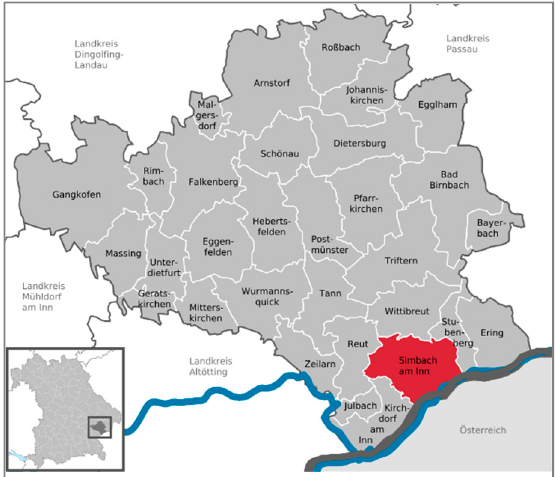
Figure 1. Location Simbach at the Inn in Bavaria, Germany (Source: https://goo.gl/images/w8KDTs, 15 December 2019).